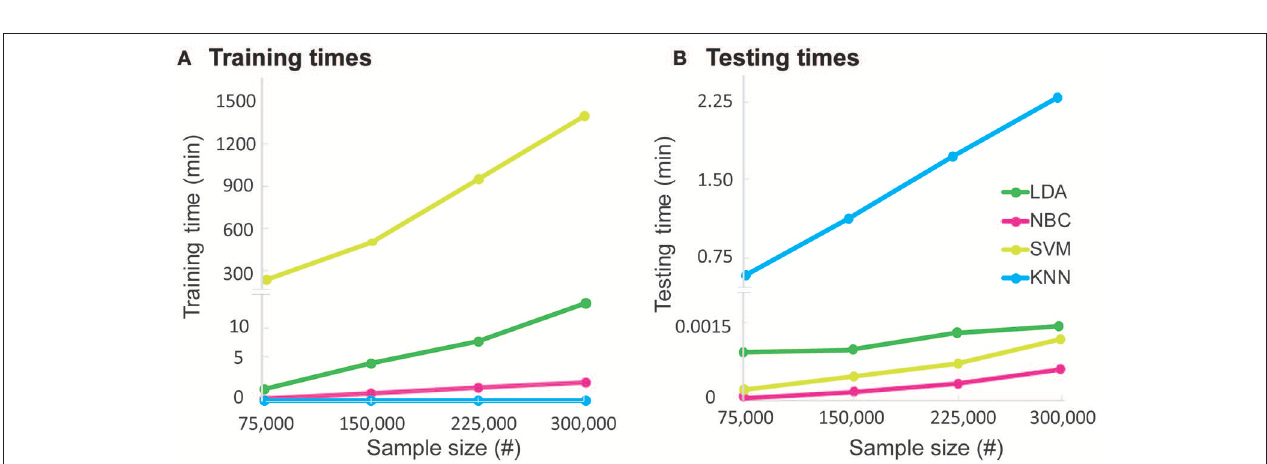
FIGURE 5 | Algorithm (A) training times and (B) testing times on real world-sized dataset. The dataset is comprised of 300,000 simulated primitives. We evaluated training and testing times required by each algorithm for quartile increases in dataset size. Please note the break in the y-axes to highlight differences in training and testing times. To avoid overfitting and compute unbiased estimates, the algorithms were trained and tested de novo at each quartile. For training with the entire dataset, SVM required the most time (1,380min) while the other algorithms required less time (LDA: 13min; NBC: 2.5min; KNN: 0min, as per model property). For testing, KNN required the most time (2.3min). The remainder of algorithms (LDA, NBC, and SVM) needed a testing time of < 0.09ms, which grew marginally with increasing sample